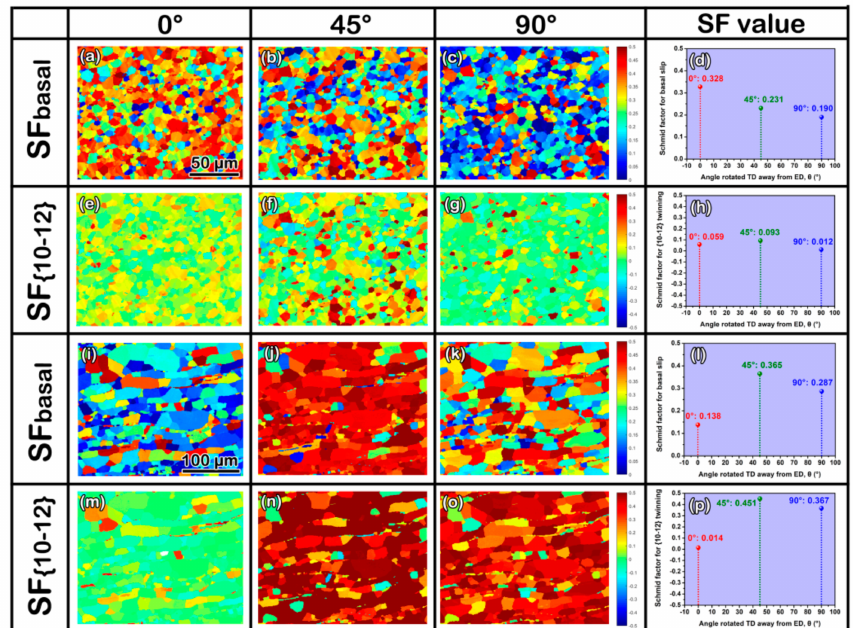
Figure 5. Schmid factor (SF) maps for basal slip of W3 ( a – c ) and L5 ( i – k ) layers and SF maps for {10–12} extension twinning of W3 ( e – g ) and L5 ( m – o ) layers applied to tension along 0 ◦ , 45 ◦ and 90 ◦ , respectively; average SF values for basal slip of W3 ( d ) and L5 ( h ) layers and average SF values for {10–12} extension twinning of W3 ( l ) and L5 ( p ) layers, respectively.